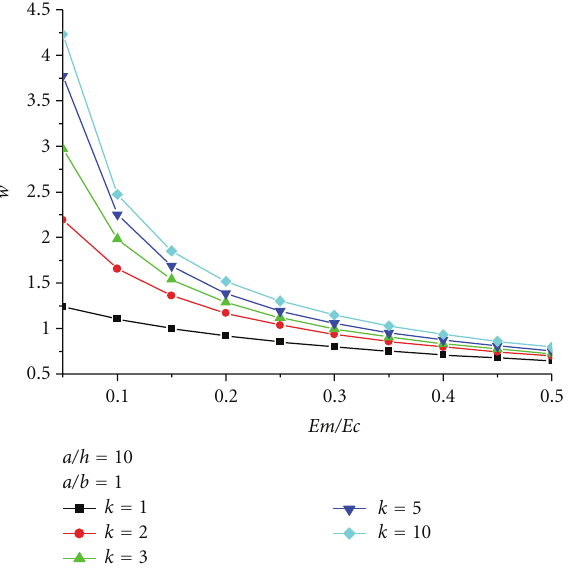
Figure 4: The e ff ect of anisotropy on the dimensionless maximum deflection ( w ) of an FGM plate for di ff erent values of k .